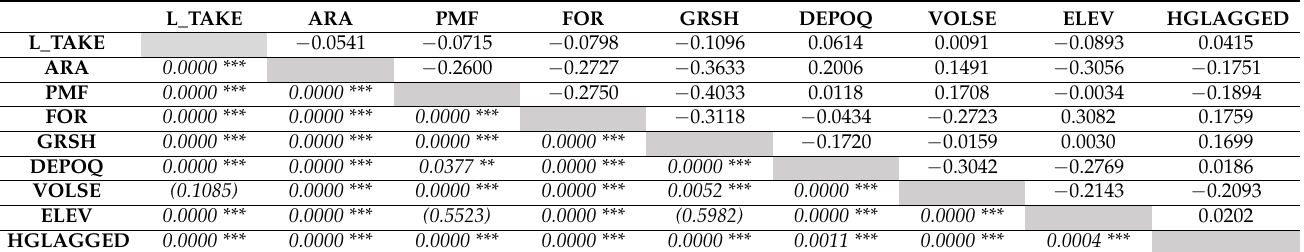
Table A1. Correlations between the explanatory variables used in model (1): Pearson product– moment correlation coefficients and significance